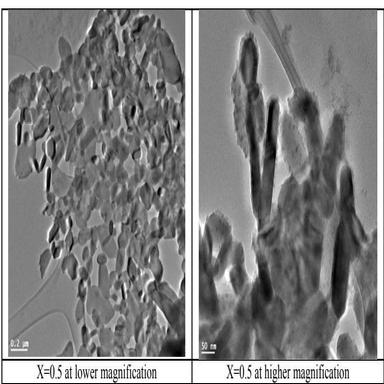
TEM micrographs for BaZnxZrxFe12-2xO19 (x= 0.50)